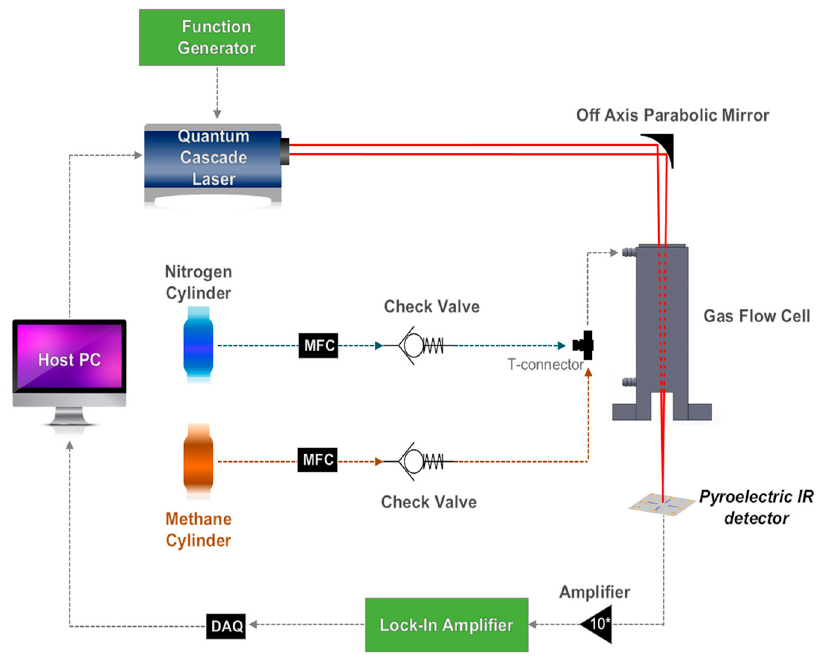
Figure 4. Schematic illustration of the experimental setup for NDIR spectroscopy.